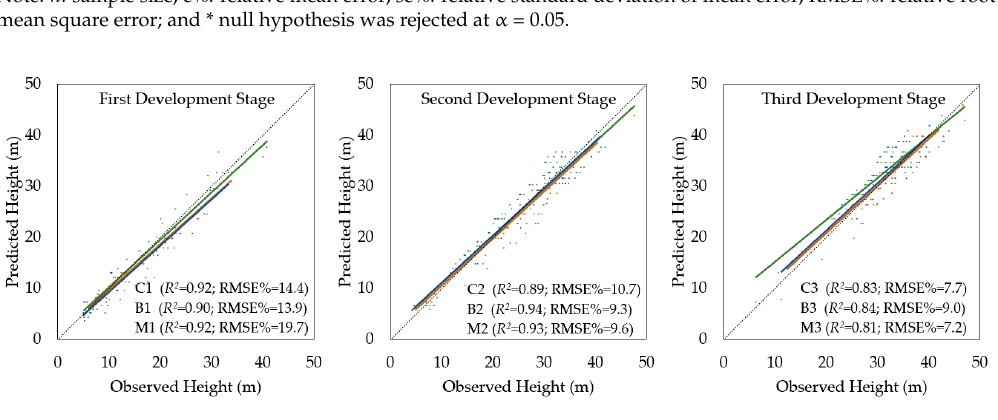
Figure 4. Regression between heights of field-measured trees (observed) and remotely-sensed trees (predicted) for coniferous strata (brown), broadleaved strata (green), and mixed strata (blue). We found that tree heights detected and corrected based on the ALS data and bias value provided an output with differences that were not statistically significant relative to the ground data ( α = 0.05). Based on the whole-sample size, the remote-based approach underestimated tree height by 0.3 ± 13%, the RMSE% was ±9.7%, and the relationship between the height of the measured and detected trees was very high ( R 2 = 0.89).